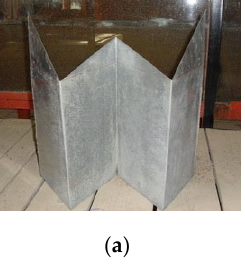
Figure 2. Plan view of laboratory flume and the test bend (all dimensions in meters).